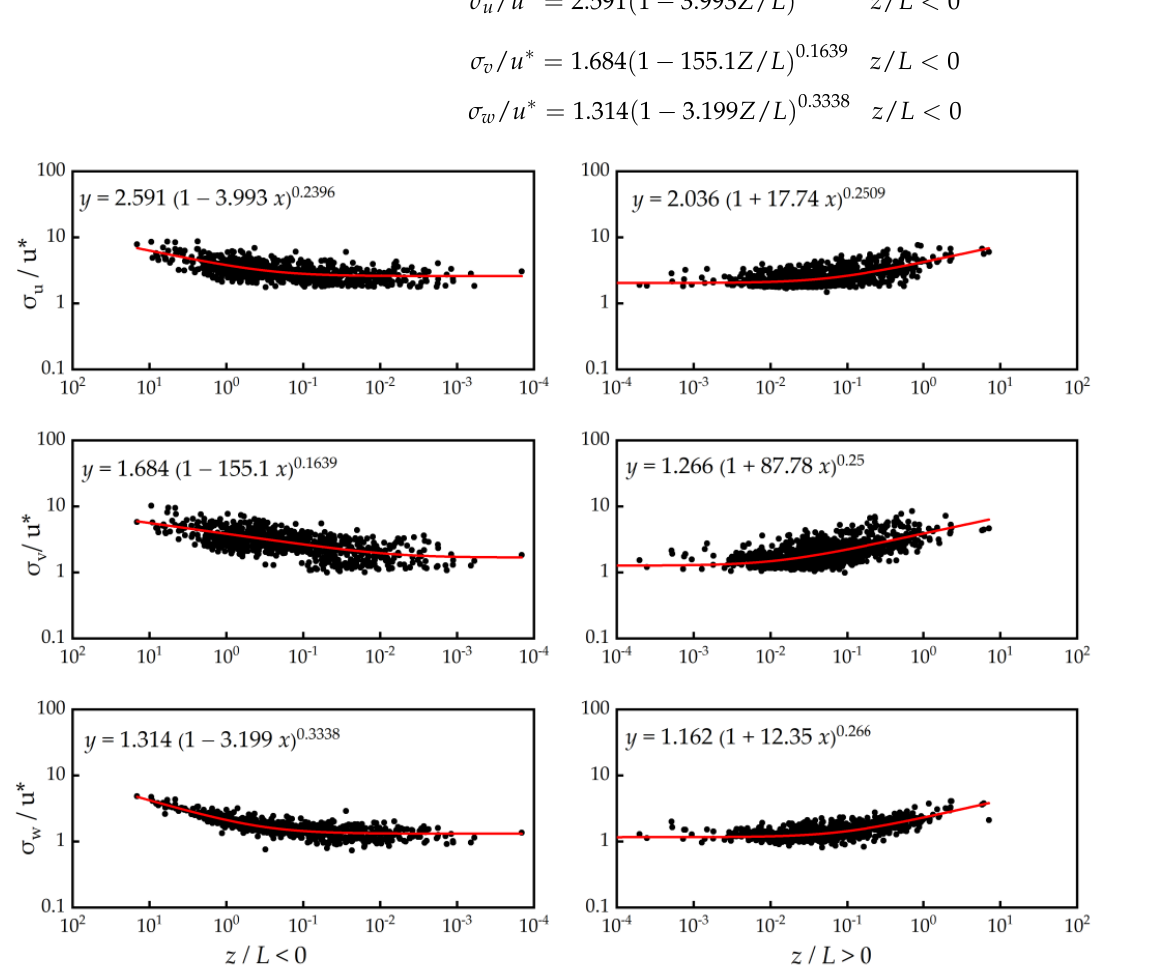
Figure 5. Variation of dimensionless wind fluctuation variance with relative stability parameters z / L at Mount Emei station.